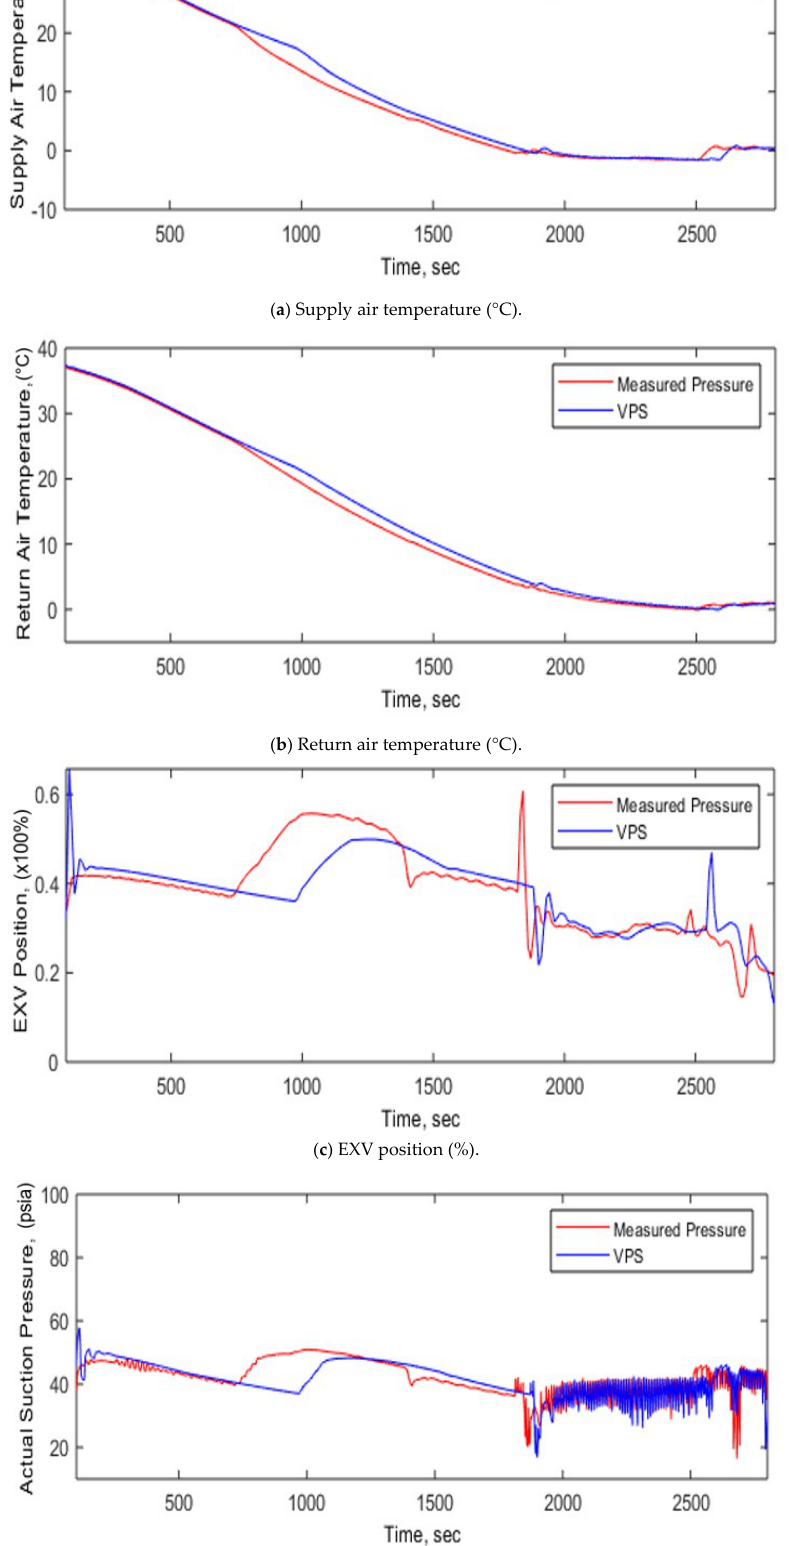
Figure 9. MIL simulation results for scenario 2.